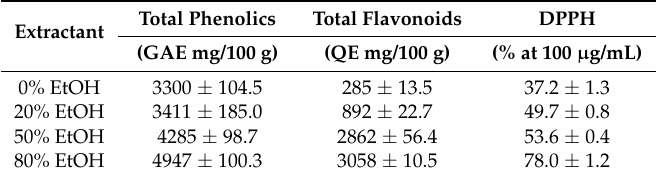
Table 1. Total phenols, flavonoids and DPPH scavenging activity in F. philippinensis